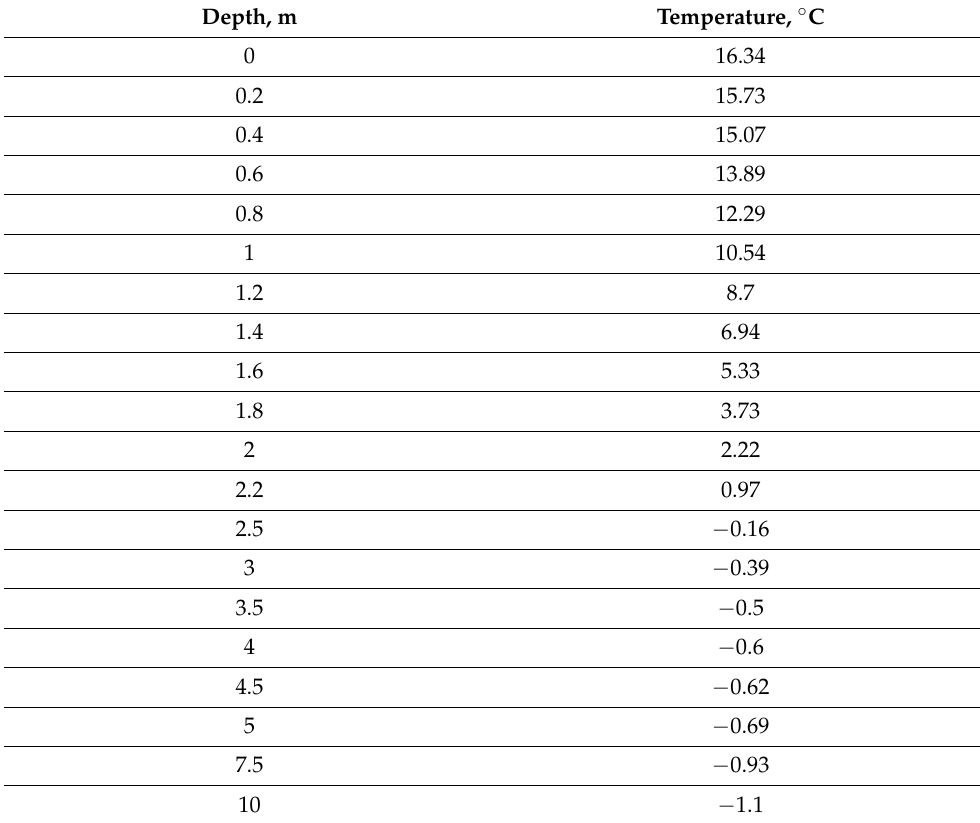
Table 2. Ground temperature distribution.